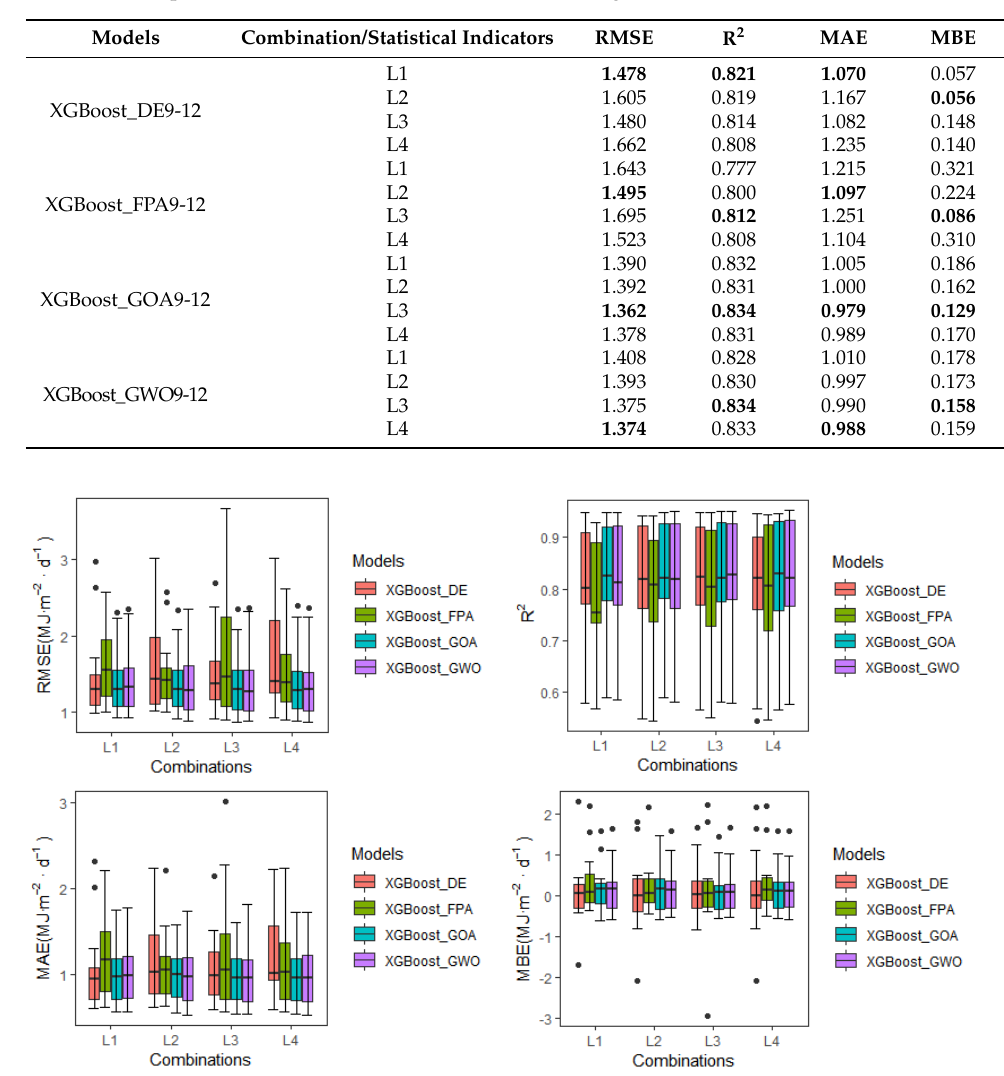
Figure 5. Boxplot of statistical indicators for the prediction of R d by the coupling model based on ground weather station data.